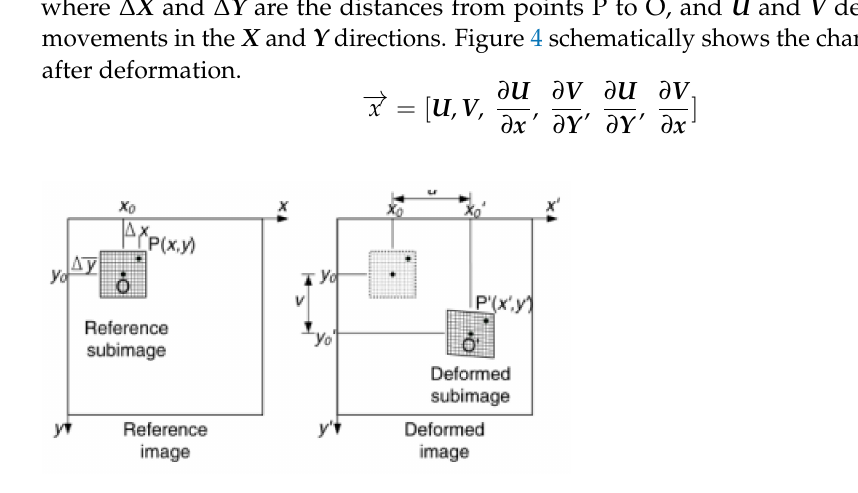
Figure 4. Deformation of tensile test before and after image